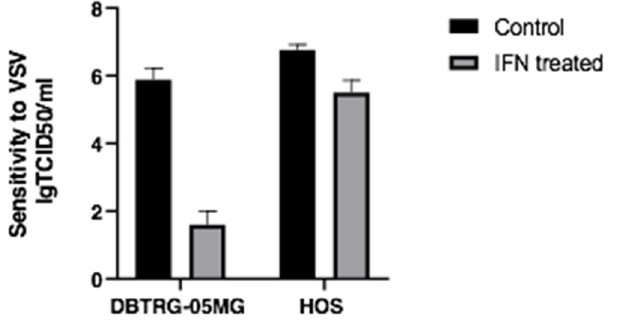
Figure 1. Sensitivity of DBTRG-05MG and HOS cell lines to vesicular stomatitis virus (VSV) with and without interferon α 2 β pretreatment (24 h, 1000 U/mL).